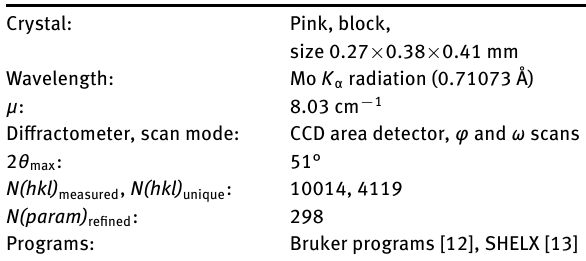
Table 1: Data collection and handling. Crystal: